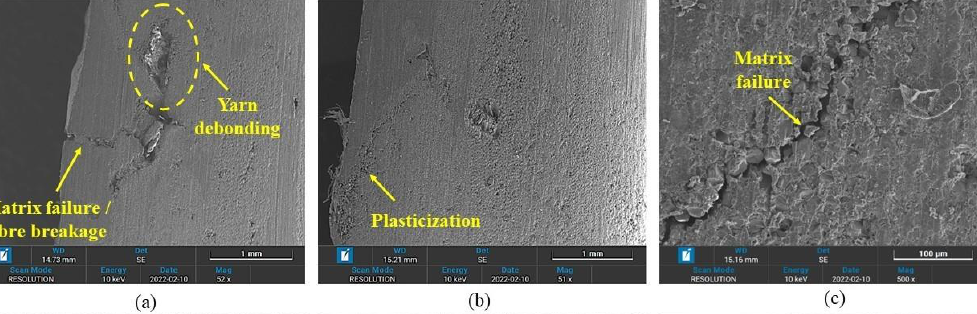
Figure 10. Comparison of intralaminar/interlaminar failure mechanisms in off- axis (30º, 45º and 90º) specimens. ( a – d ) TP-3D-FRC and ( e – i ) TS-3D-FRC. 3.5.2. Interlaminar Failure Mechanisms The off-axis behaviour of the 3D orthogonal woven composite is highly nonlinear due to the plasticization of resin-rich pockets and progressive damage of the matrix, which was attributed to the re-orientation of yarns. During the re-orientation process, the debonding/delamination of yarns and matrix occurs (see Figures 9 and 10). The re-orien- tation between warp and fill yarns is shown in Figure 8. (Represented with blue and red lines). Moreover, Elium ® - based 3D-FRC shows significantly reduced delamination (see Figure 9f,g) due to their higher interlaminar fracture toughness and strong fibre/matrix interface [43]. In contrast, extensive fill yarn debonding was identified in the Epolam ® - based 3D-FRC due to the re-orientation of warp and fill yarns (Figure 9h,i). The off-axis specimens (45° and 60°) show significant debonding of fill yarns at the edges of the spec- imens in both 3D textile composites, as shown in Figure 11. Thermoplastic off-axis speci- mens show large out-of-plane permanent deformation after unloading due to the locking of yarns caused by plasticization during the loading process.